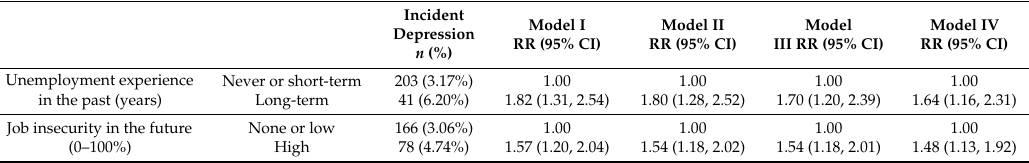
Table 2. Separate effects of unemployment experience and job insecurity at baseline on depression at follow-up ( n = 7073).